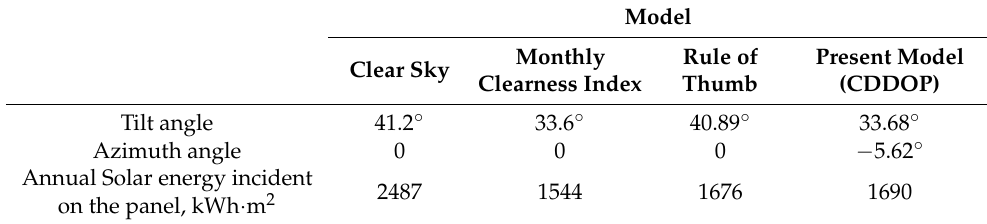
contour plot shows that small changes in the orientation of the panel result in a negligible DC power Table 1. A comparison of optimum tilt angle and total incident irradiation on a solar panel calculated using present model (CDDOP), clear sky, clearness index and rule of thumb at Riverdale, NY, USA. Model Monthly Rule of Present Model Clear Sky Clearness Index Thumb (CDDOP) Tilt angle 41.2 ◦ 33.6 ◦ 40.89 ◦ 33.68 ◦ Azimuth angle 0 0 0 − 5.62 ◦